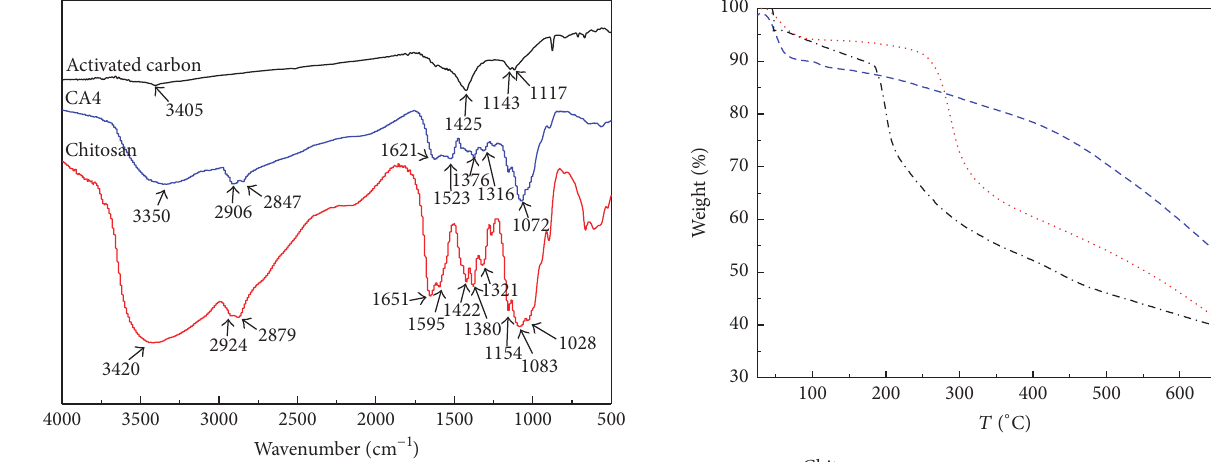
Figure 3: FTIR spectra of activated carbon, CA4, and chitosan.